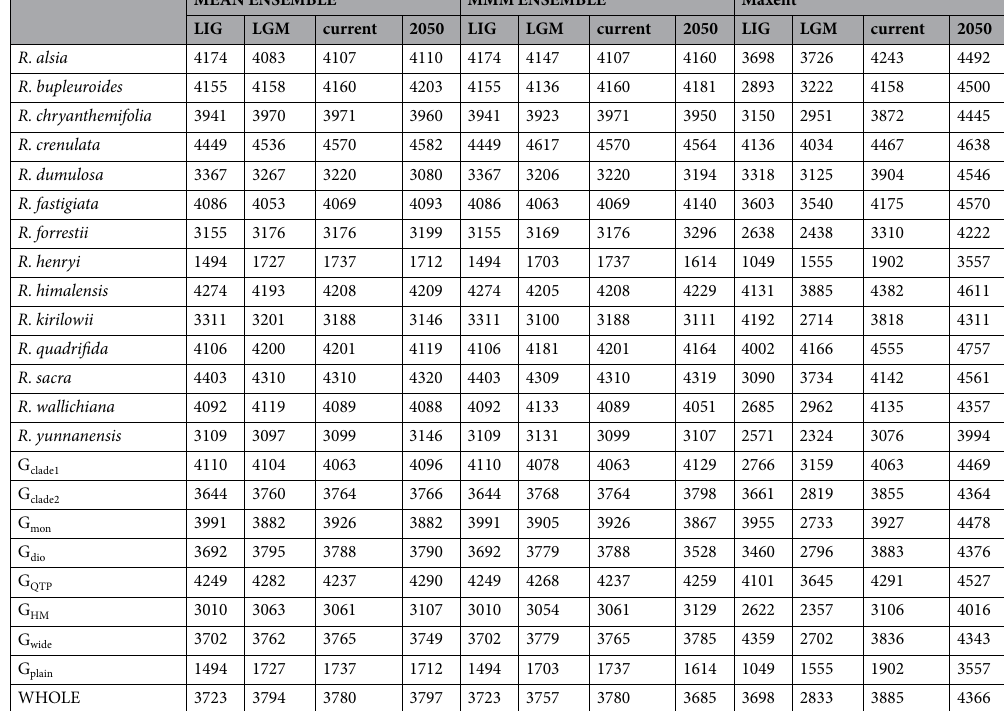
Table 3. Predicted mean elevation (m) of Rhodiola species and species groups for each time period using MEAN ENSEMBLE, MMM ENSEMBLE and